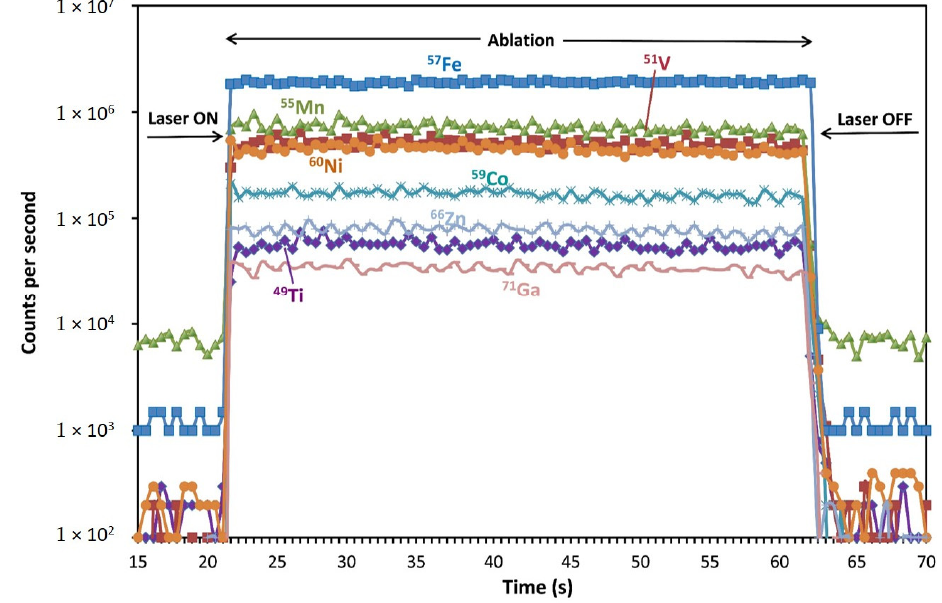
Figure 2. Representative time-resolved LA-ICP-MS depth profiles for a spinel (logarithmic scale) with a few selected isotopes shown (primary Cr-spinel from Spl-Grt lherzolite sample DK-8/3; beam diameter is 65 μ m). From the left, the background count is 23 s (not shown completely), followed by 42 s of the ablation time, which is integrated and by 40 s of the wash-out time (not shown completely).